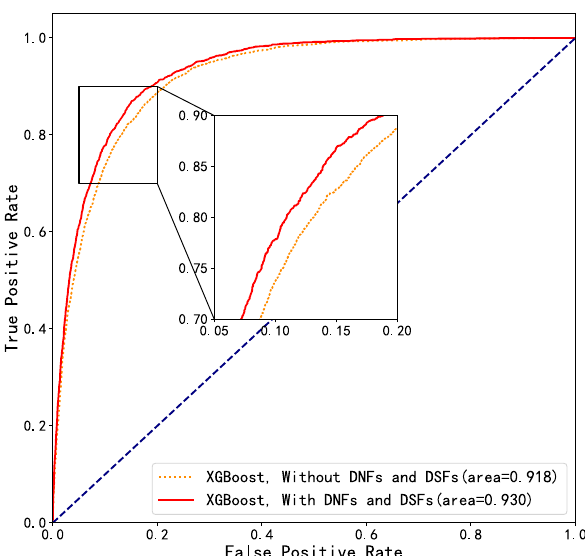
Figure 1. Receiver operating characteristic (ROC) curves of models with/without DNFs and DSFs using XGBoost classifier.